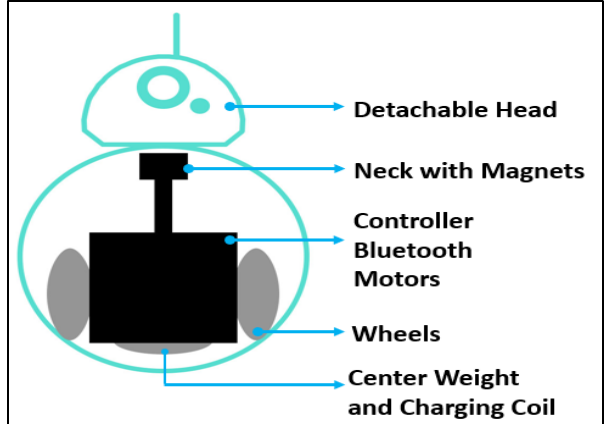
Figure 4. The Sphero BB-8 Droid